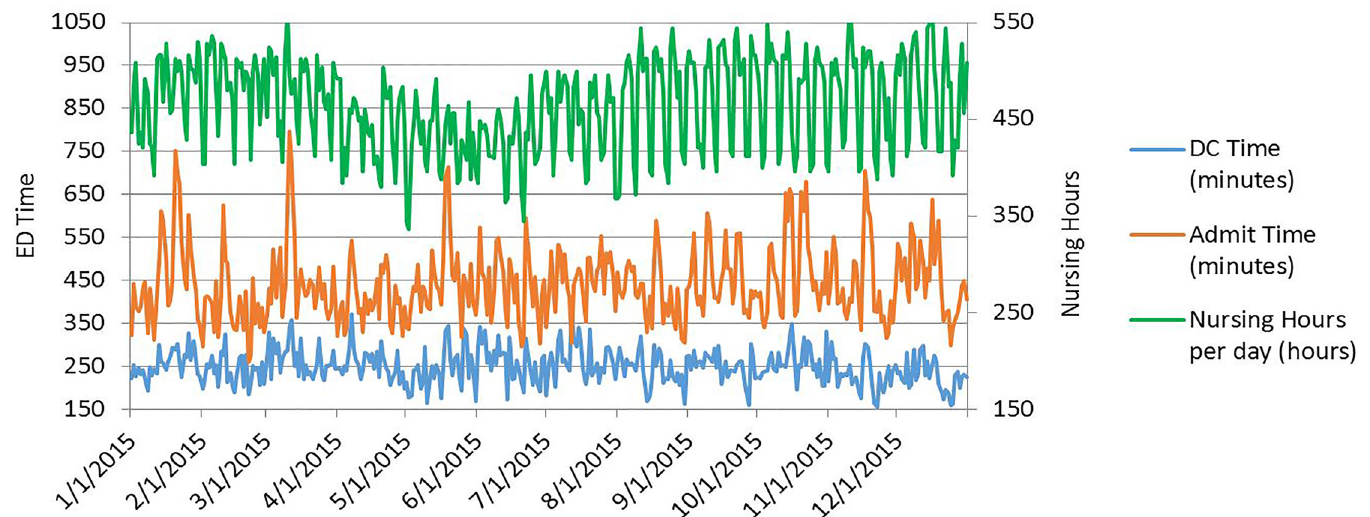
Figure. Daily mean length of stay for discharged and admitted patients as well as daily nursing hours by date. ED , emergency department; DC ,